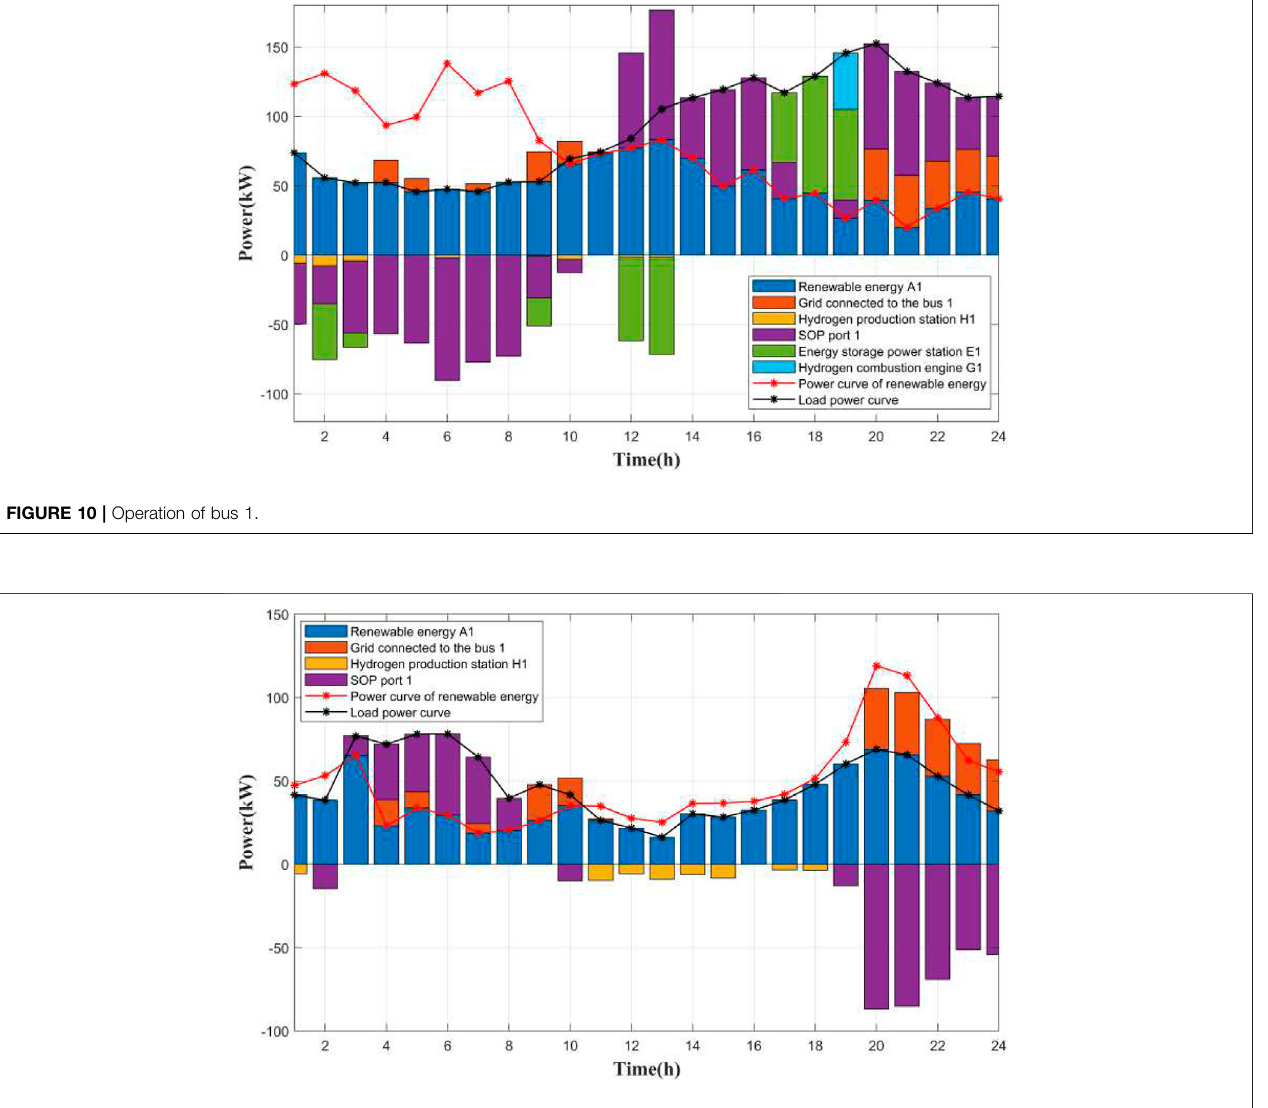
FIGURE 11 | Operation of bus